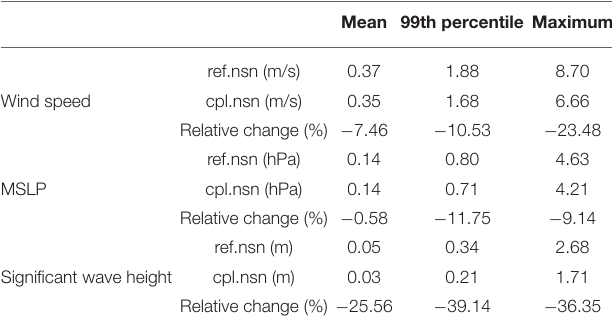
TABLE 3 | Evaluation of ensemble